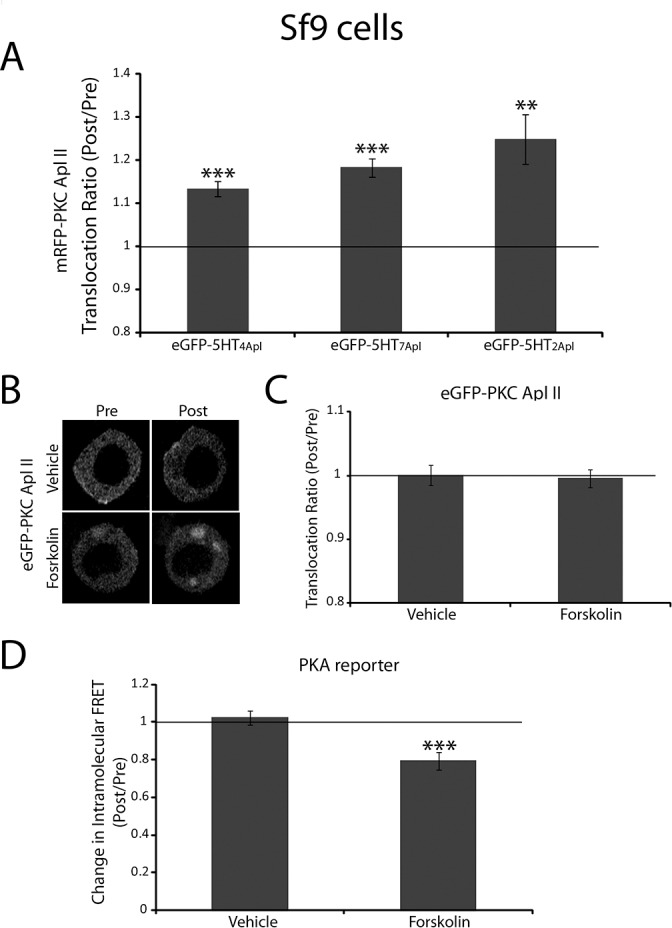
Adenylate cyclase activation does not cause translocation of PKC Apl II in response to 5HT in Sf9 cells.A) Sf9 cells were cotransfected with mRFP-PKC Apl II along with either eGFP-5HT4Apl (n = 17), eGFP-5HT7Apl (n = 15) or eGFP-5HT2Apl (n = 9). Cells were treated with 5HT (10 μM) for 5 min and PKC Apl II translocation ratio (Post/Pre treatment) was quantified as described in methods. The bar graph shows the average of the translocation ratios measured at 60, 90, 120 and 150 sec after the addition of 5HT to the dish normalized to the Pre 5HT group. A paired Student’s t test was used to compare translocation post 5HT to pre 5HT for each group, ***p<0.001, **p<0.01 after correction for multiple tests with Bonferroni correction. Error bars indicate SEM. B) Representative confocal fluorescence images of Sf9 cells expressing eGFP-PKC Apl II before forskolin (100 μM) treatment or 6 min following forskolin (100 μM) treatment. C) The translocation ratio (Post/Pre) was quantified for the cells shown in B. No translocation was noted for the forskolin group (n = 12) or the vehicle group (n = 9). D) Change in intramolecular FRET (Post/Pre) was calculated for Sf9 cells co-expressing the regulatory subunit of PKA tagged with CFP (RII-CFP) and the catalytic subunit tagged with YFP (C-YFP) that were treated either with vehicle (n = 9) or with forskolin (100 μM; n = 10) for 4 min. cAMP production downstream of forskolin treatment and its binding to the regulatory subunits of PKA causes dissociation of the regulatory and catalytic subunits of PKA leading to a loss of FRET. A paired Student’s t test was used to compare the FRET ratio Post-treatment to Pre-treatment for each condition. Forskolin treatment caused a significant decrease of the FRET ratio, ***p<0.001. Error bars indicate SEM.